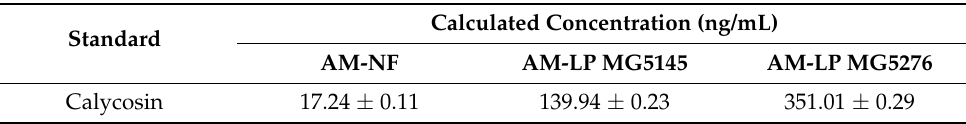
Figure 3. The chromatograms of calycosin (standard; 100 ppm). Each sample was analyzed using UPLC-ESI-MS/MS. The black peak on each chromatogram indicates the standard. Table 4. The ultra-performance liquid chromatography ionization-mass spectrometry of calycosin (UPLC-ESI-MS/MS).